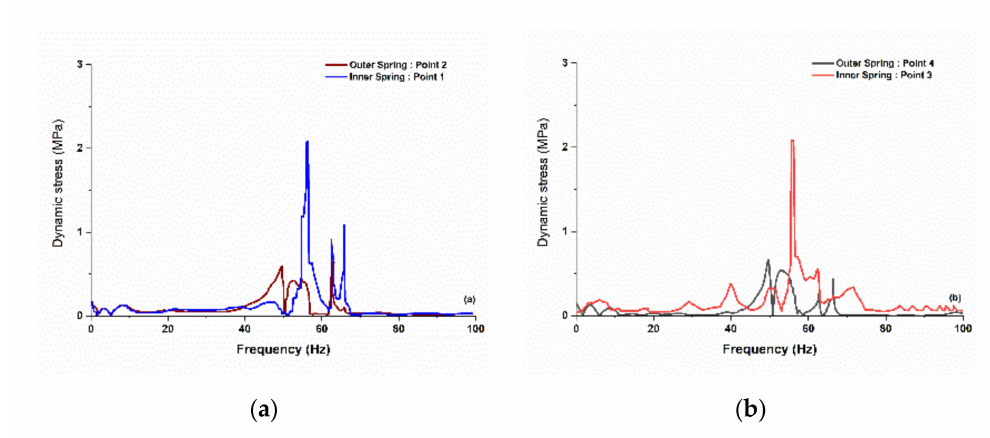
Figure 11. Dynamics stress at the 1.5-circle position of inner and outer springs: ( a ) lower and ( b ) upper positions.